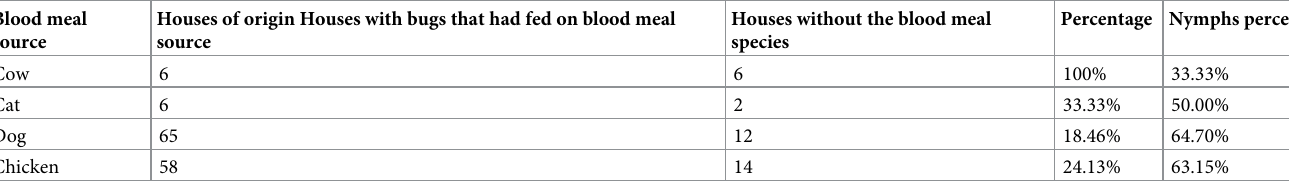
Table 2. Presence of species compared to the blood sources